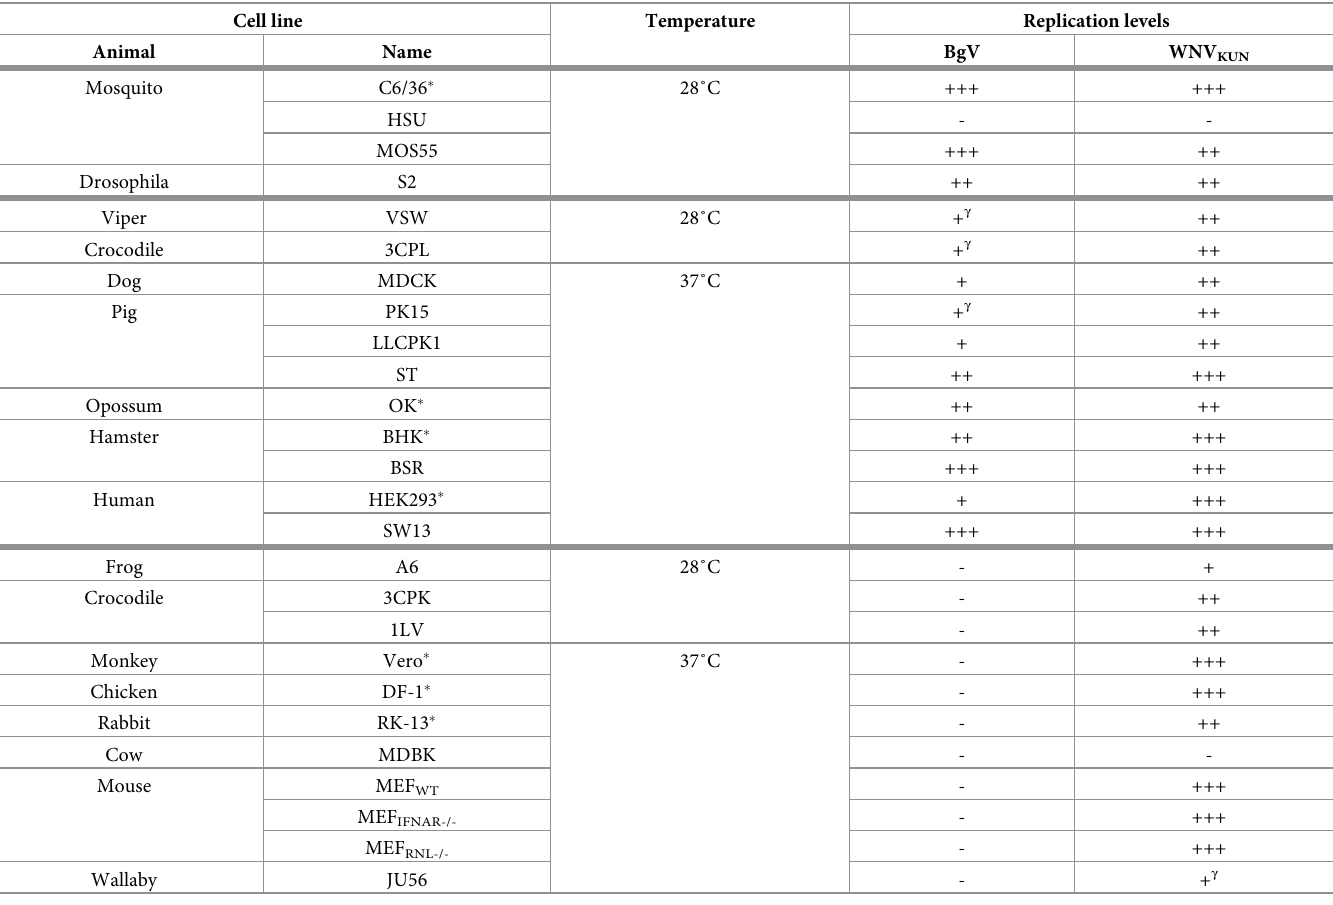
Table 1. Replication of BgV in insects and vertebrates. Insect and vertebrate cell lines were inoculated in triplicates with BgV and WNV at MOI 1 for 1h 30min, the inoculum removed and the cells washed before incubating the replenished cultures at 28˚C or 37˚C. The inoculated cell culture supernatants were harvested five days p.i., titrated on C6/36 cells and analysed by fixed-cell ELISA.—represents no replication, + represents a titre over 10 2 TCID 50 IU/mL, ++ represents a titre over 10 4 TCID 50 IU/ mL, +++ represents a titre over 10 6 TCID 50 IU/mL. In a few instances, not all replicates were positive, in which case the titre represented is the average of the positive repli- cates